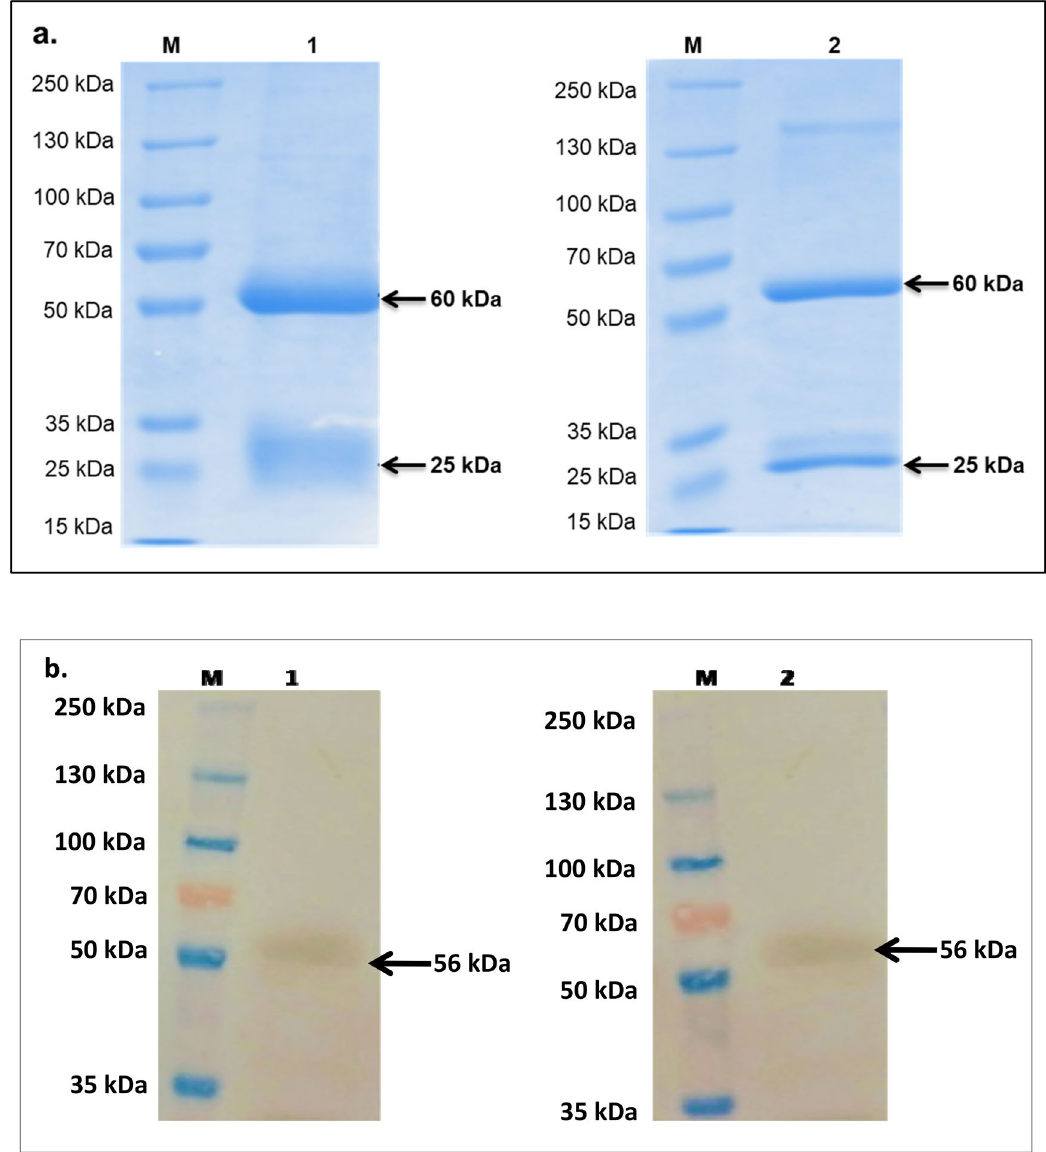
Figure 2. ( a ) 10% SDS-PAGE analysis of antibodiesraised against recombinant nucleoprotein. Lane 1 was loaded with polyclonal antibody and Lane 2 was loaded with monoclonal antibody (CCHF_mAb2) revealing characteristic heavy chain (60 kDa) and light chain (25 kDa) of antibodies. ( b ) Western blot analysis using polyclonal (Lane 1) and monoclonal (CCHF_mAb2) (Lane 2) antibodies showing immune reactivity with 56 kDa recombinant nucleoprotein (NP) of CCHF